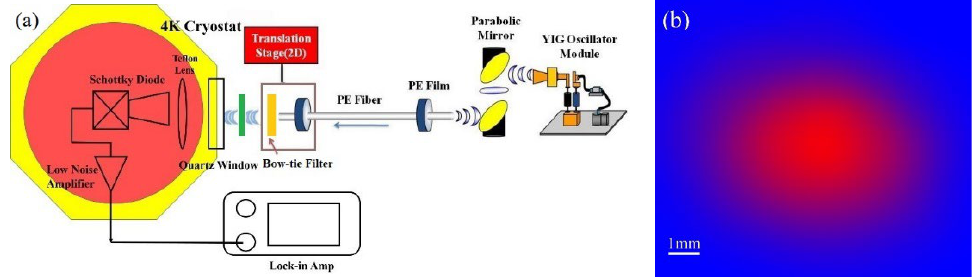
Figure 1. ( a ) Schematic diagram of the THz near-field imaging system. ( b ) A direct 2D 10 mm × 10 mm scanning image of air.